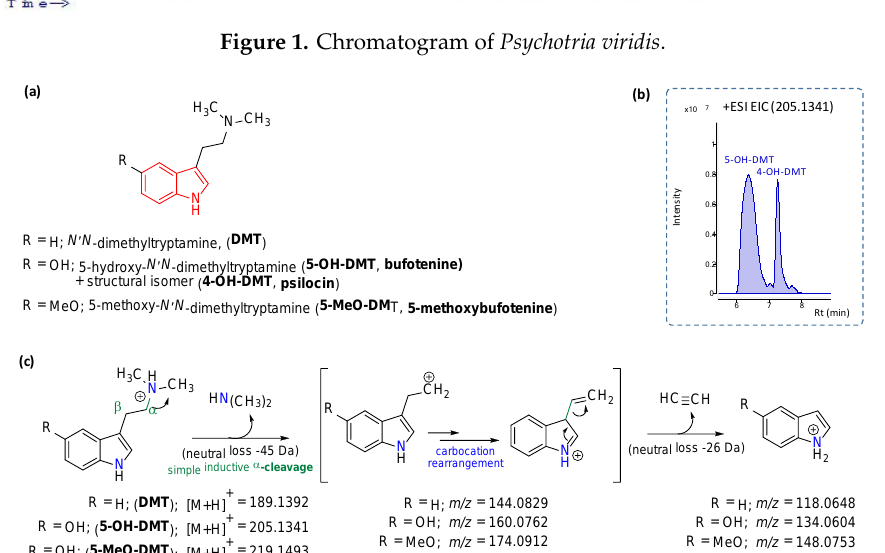
Molecules 2020 , 25 , x FOR PEER REVIEW Figure 1. Chromatogram of Psychotria viridis .